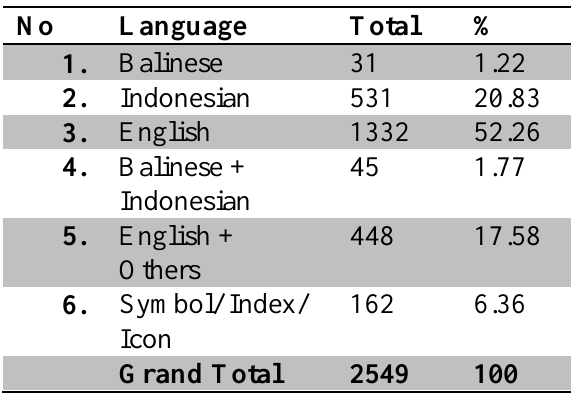
Table 2. The Language of